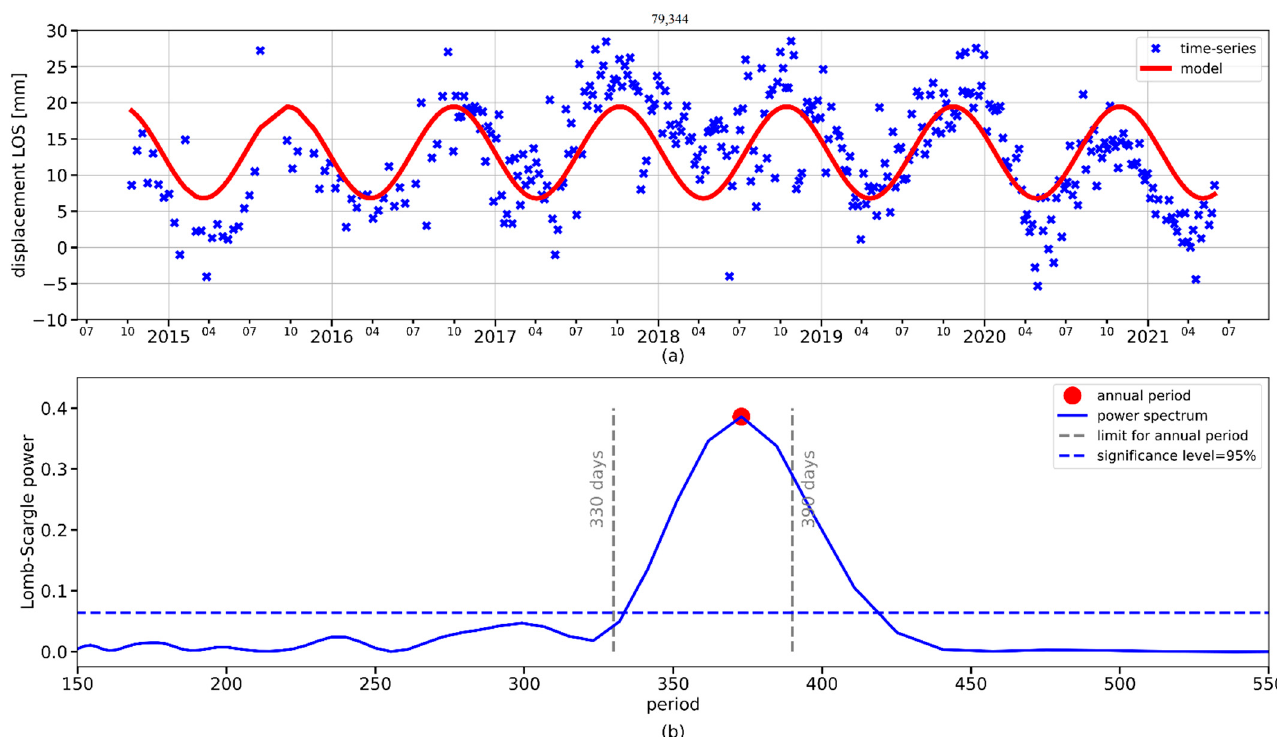
Figure 4. The Lomb ‐ Scargle periodogram. ( a ) The plot shows the time series of a single point over the UGS (blue cross), the red plot shows the model constructed from the periodogram. ( b ) The plot shows the power spectrum; it can be seen that the main period corresponds to roughly one year.